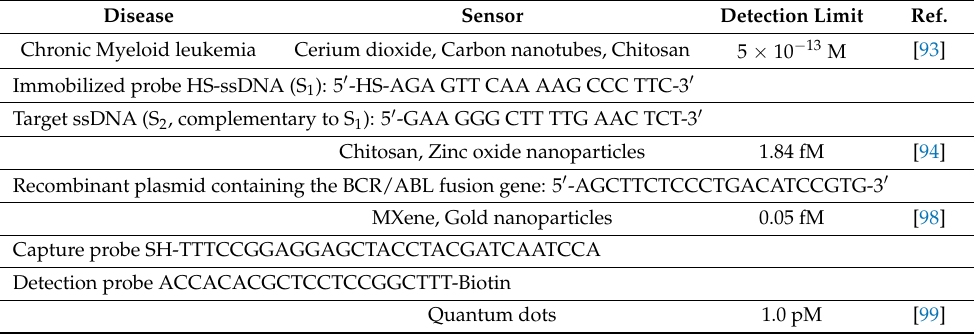
Table 2. Possible biosensors for BCR/ABL detection. Disease Sensor Detection